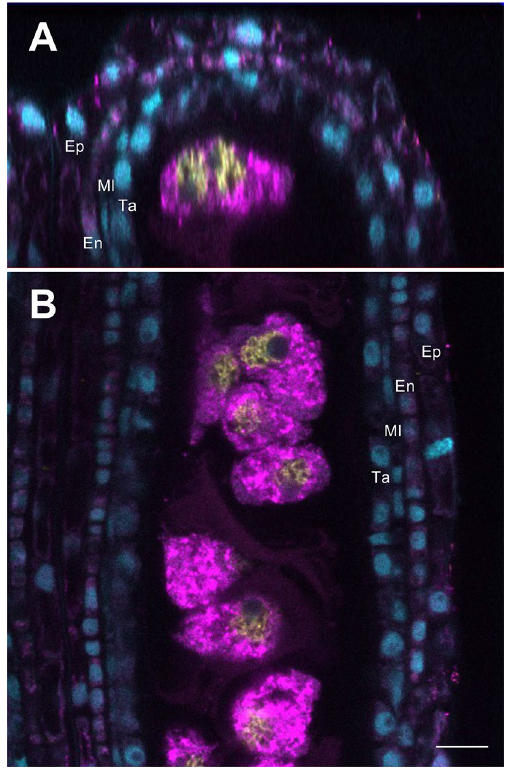
Figure 3. Cross and longitudinal sections for 3D anther immunoimaging using a confocal microscope. ( A ) A cross-section (X section) of the 3D anther immunoimaging, in which 0.65-mm anthers from the early meiosis stage were used. ( B ) A longitudinal section (Z section) of the 3D anther immunoimaging. The four somatic layers, epidermis (Ep), endothecium (En), middle layer (Ml), and tapetum (Ta), were observed. The cytoplasmic localization of MEL1 (magenta) and nuclear localization of ZEP1 (yellow) fluorescence signals were observed in meiocytes surrounded by the somatic anther wall. Cyan signals indicate DAPI staining. Scale bar, 10